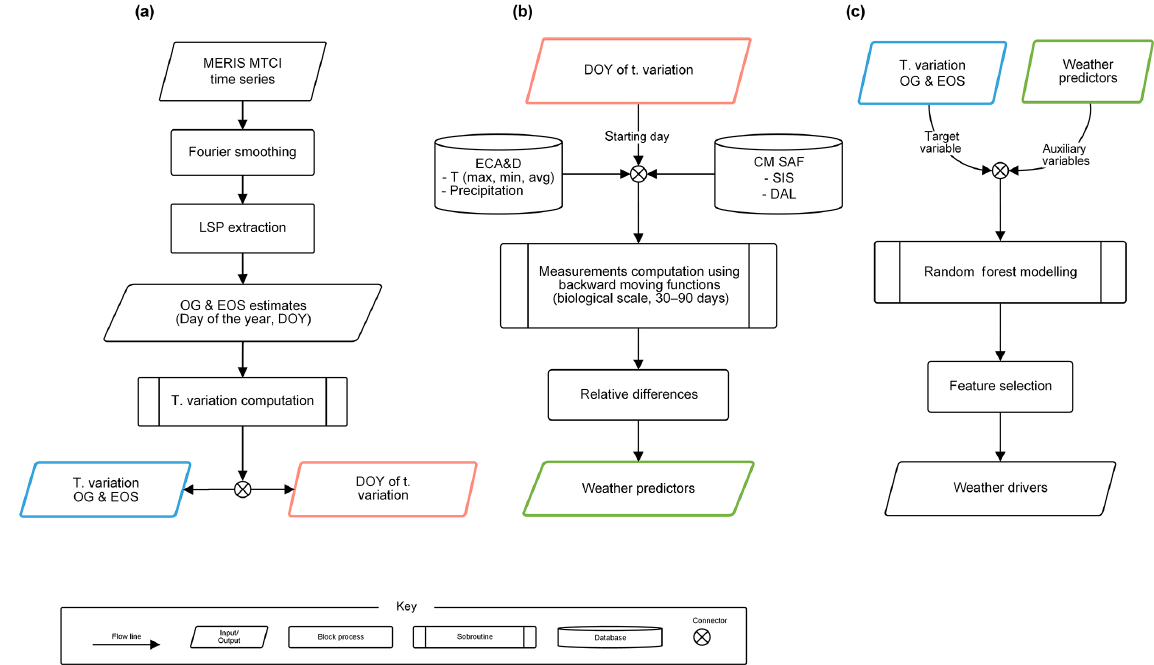
Figure 2. Flowchart illustrating the methodology. (a) Phenology extraction and interannual variation in LSP computation. (b) Computation of weather predictors. (c) Modelling of interannual variation in